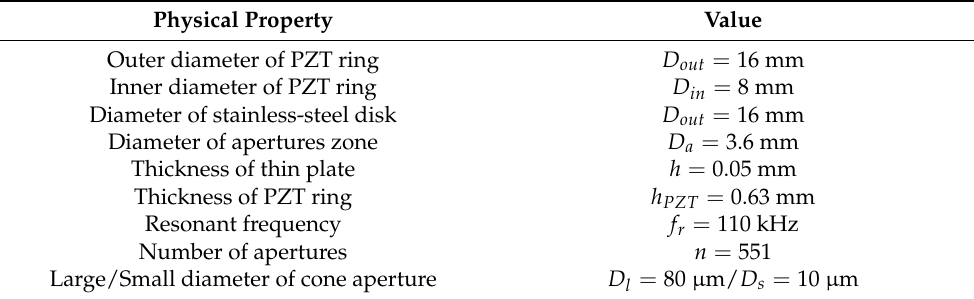
Table 4. Atomizer physical properties.